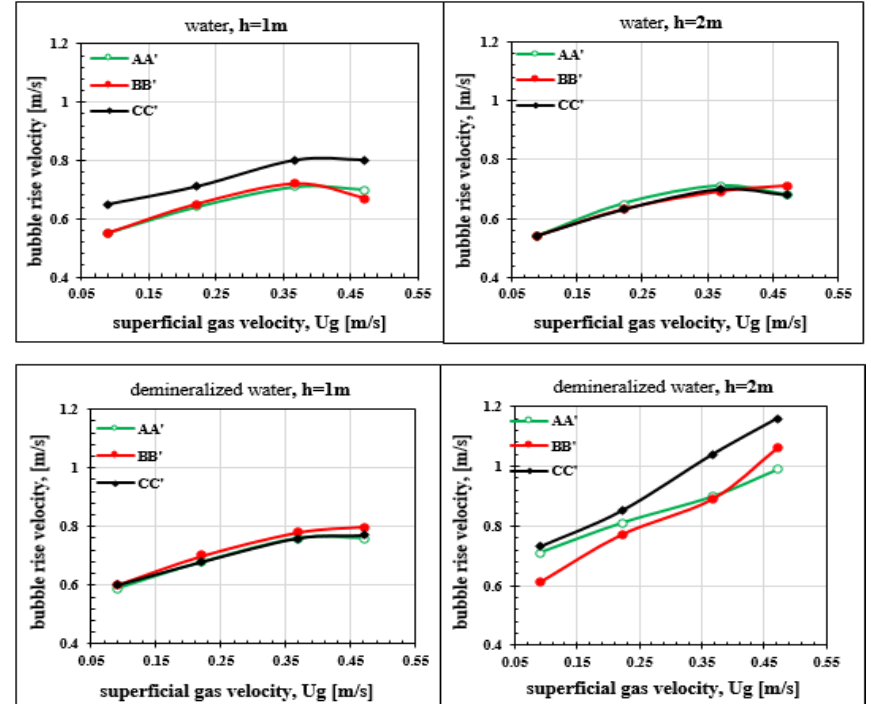
Figure 18. Relationship between bubble rise velocity and superficial gas